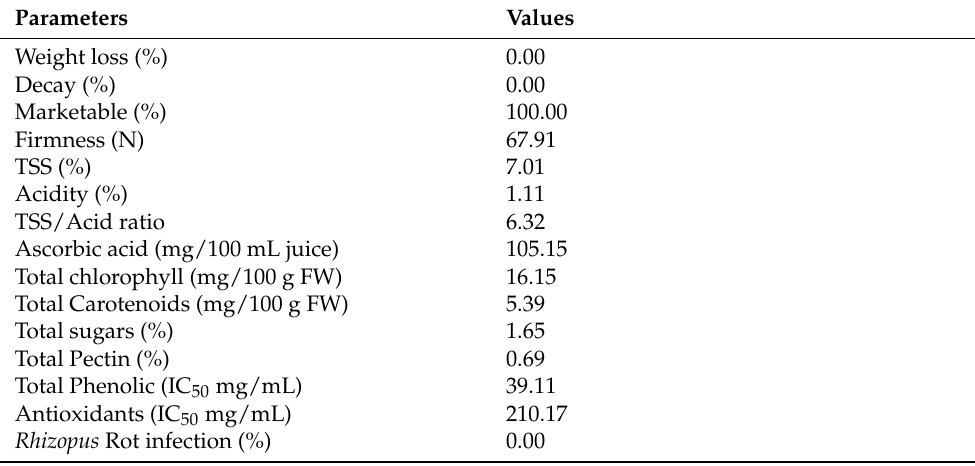
Table 1. Characteristics of guava fruit prior to